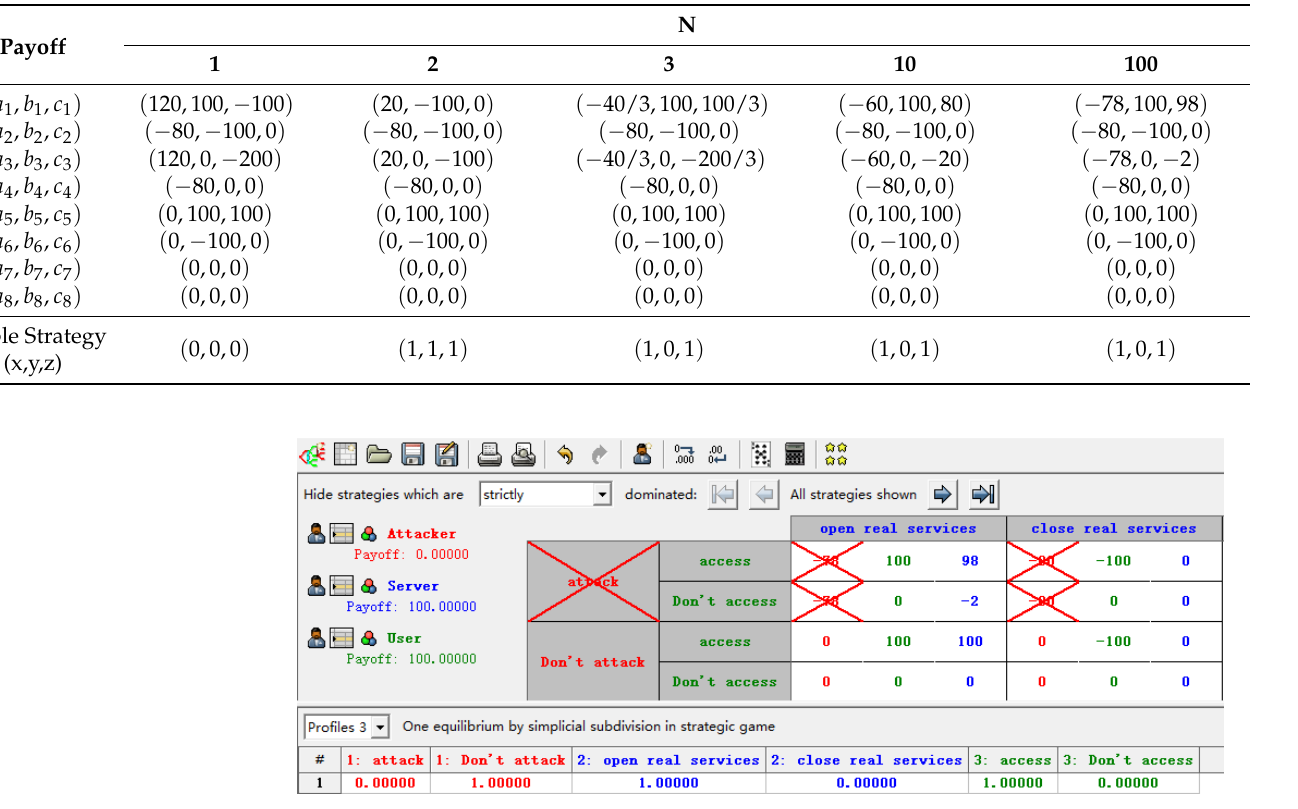
Figure 5. The stabilized Gambit experiment result of real